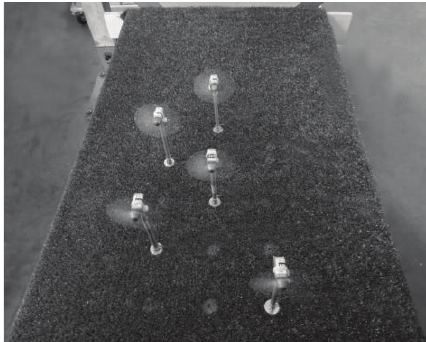
Figure 5: Photograph of the wind farm in the wind tunnel test section.